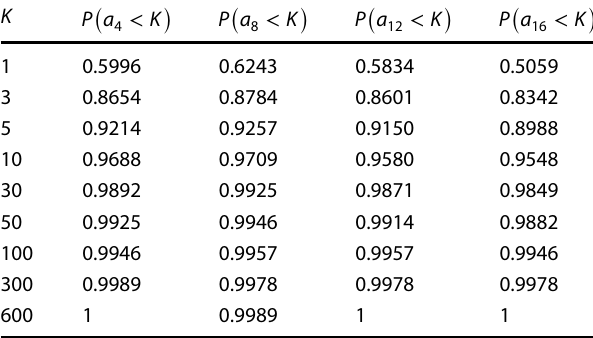
Table 2 Probability distribution of the 4th, 8th, 12th, and 16th coef- ficient for the AUD/CAD exchange